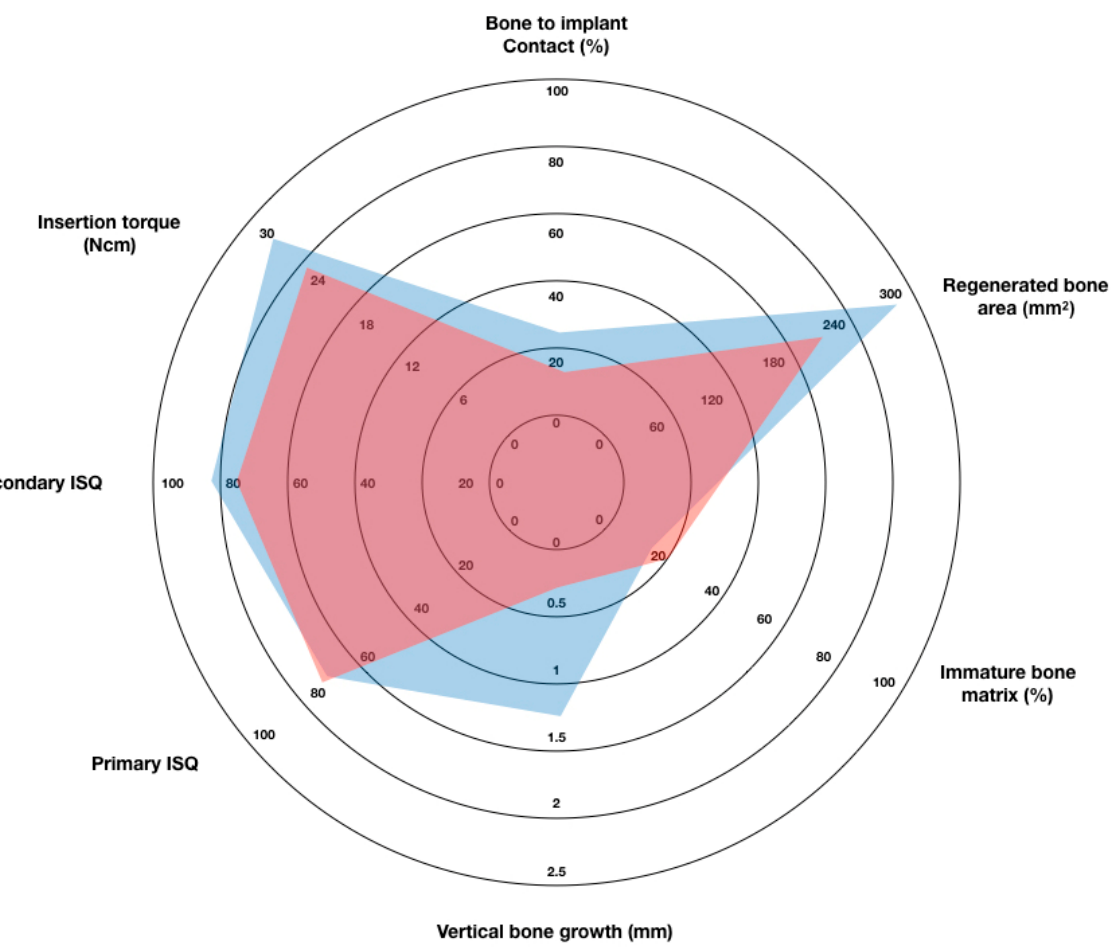
Figure 4. Graphic representation of the analysed stability and histomorphometric variables. Blue area represents Group A (test) and red area represents Group B (control).